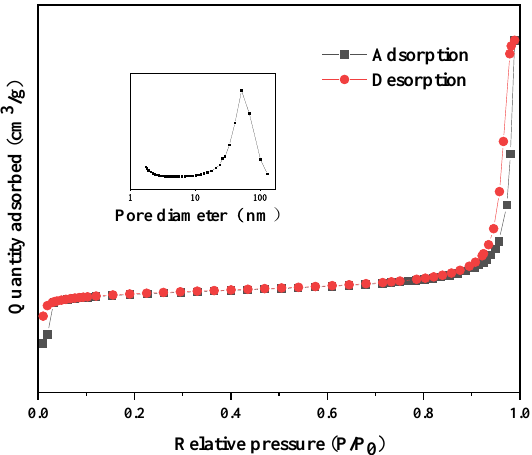
Figure 6. Nitrogen adsorption and desorption isotherms of ZIF-8. Table 1. Surface area and porous structure of the